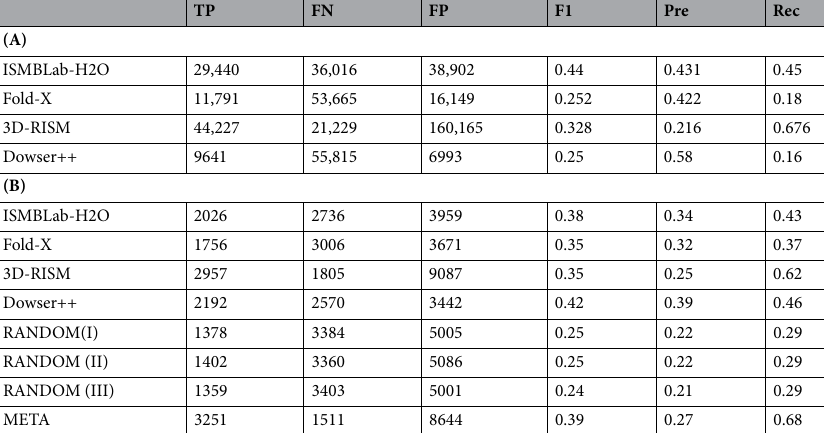
Table 1. Water molecule placement prediction performances benchmarked with water structures derived from X-ray crystallography. The ISMBLab-H2O benchmark results are compared side-by-side with